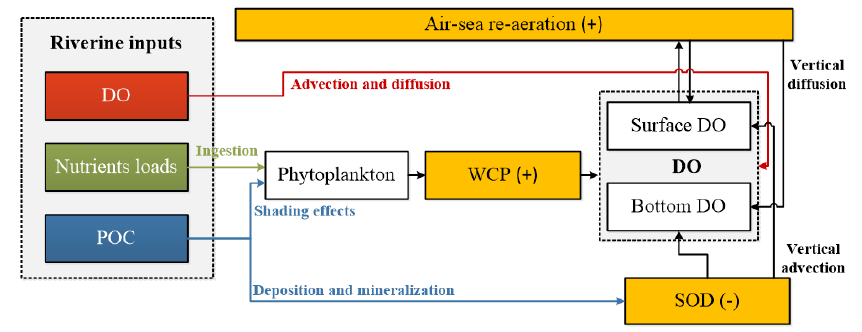
Figure 11. Conceptual schematic of the oxygen dynamics in response to riverine inputs in the PRE. The white boxes represent the state variables in the water column, the orange boxes represent the source and sink processes associated with the oxygen dynamics. The positive signs represent the sources, while the negative signs represent the sinks for DO